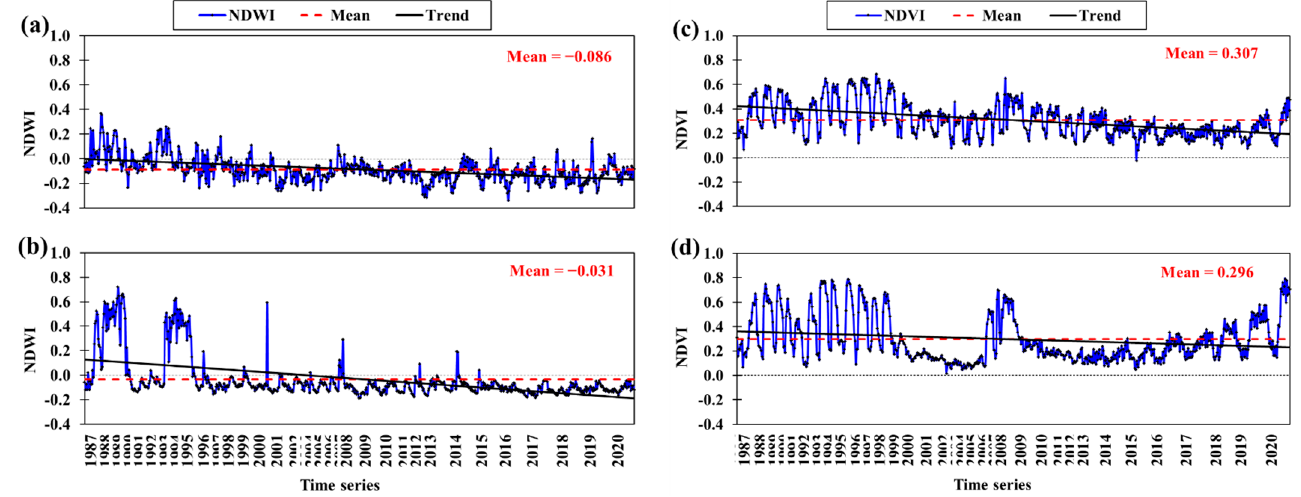
Figure 3. Time series values of NDWI at the selected points: ( a ) W1; ( b ) W2, and NDVI at the selected points: ( c ) V1; ( d ) V2, from 1984 to 2020.